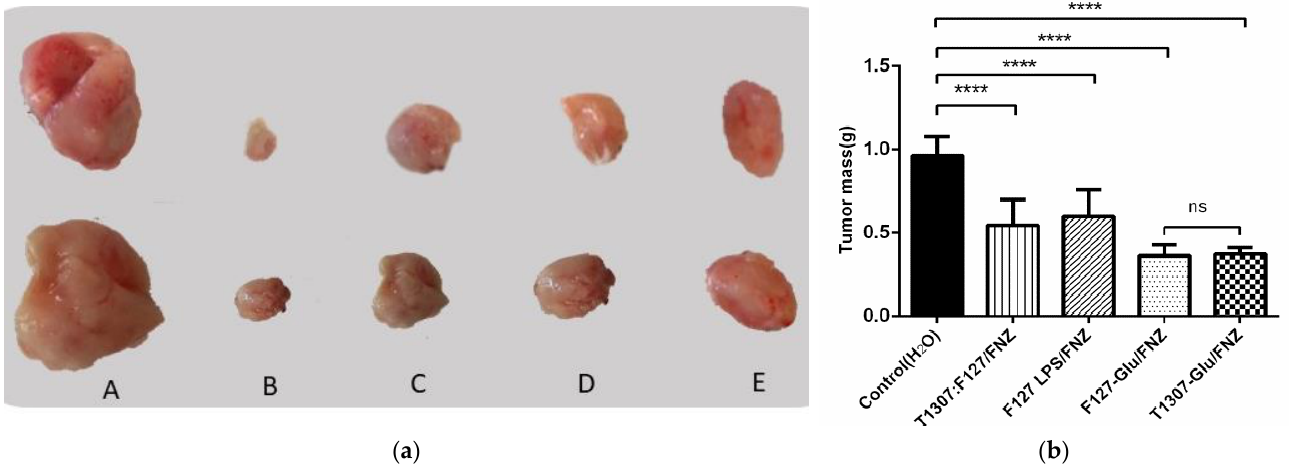
Figure 5. In vivo IP antitumoral evaluation with the different treatments: ( a ) Illustrative photographs of post treatment ex vivo tumors (showing two animals per treatment), with control (Milli-Q water, (A)), F127-Glu/FNZ (B), T1307-Glu/FNZ (C), T1307:F127/FNZ (D) and F127:LPS/FNZ (E) (20 mg/kg of FNZ). The tumor of (E) is shelled (non-solid); ( b ) Tumor masses at the end of IP treatments. **** Statistically very significant reduction of tumor weight comparing the control (tumor without treatment) with nanoformulations. ns there is no statistical significance. Note: animals per treatment = 6.